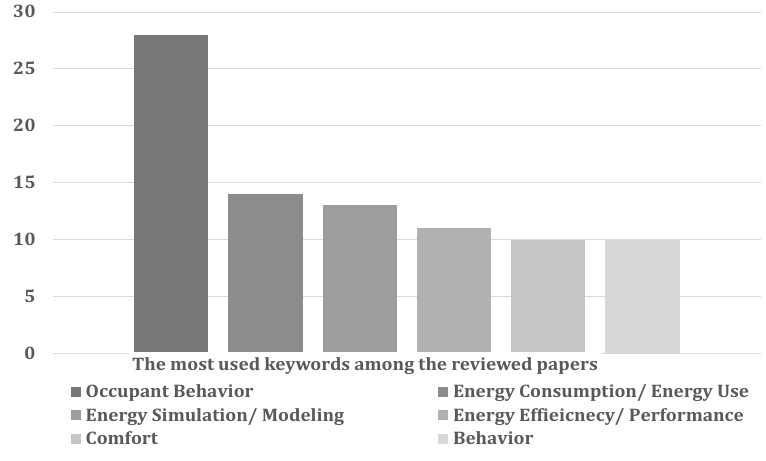
Figure 3. Frequency of keywords used in 43 journals. Reprinted with permission from Ref.